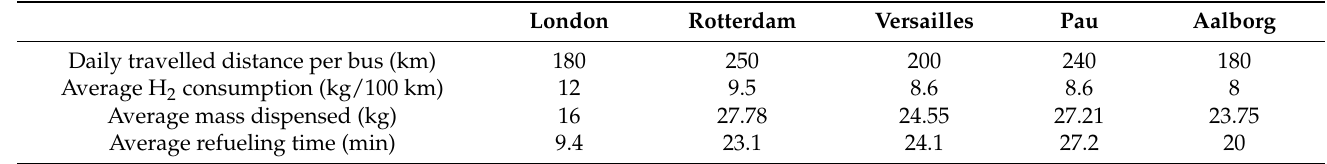
Table 2. Data used as the basis for the scale-up model.